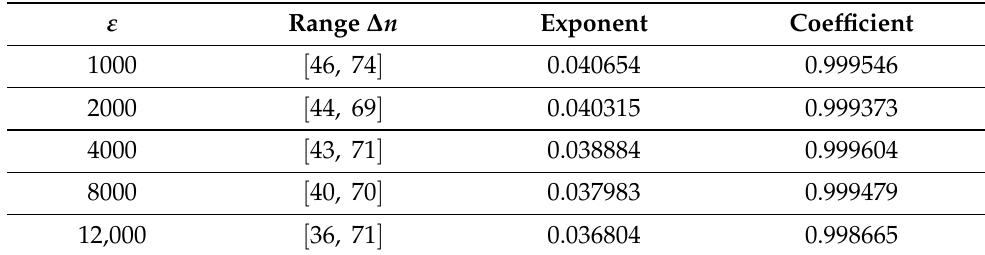
Table 4. Maximal Lyapunov exponents for